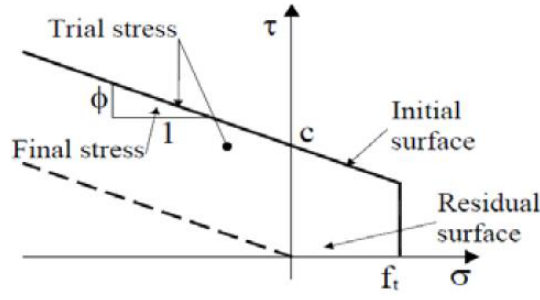
Figure 15. Failure surface for interface element [35].